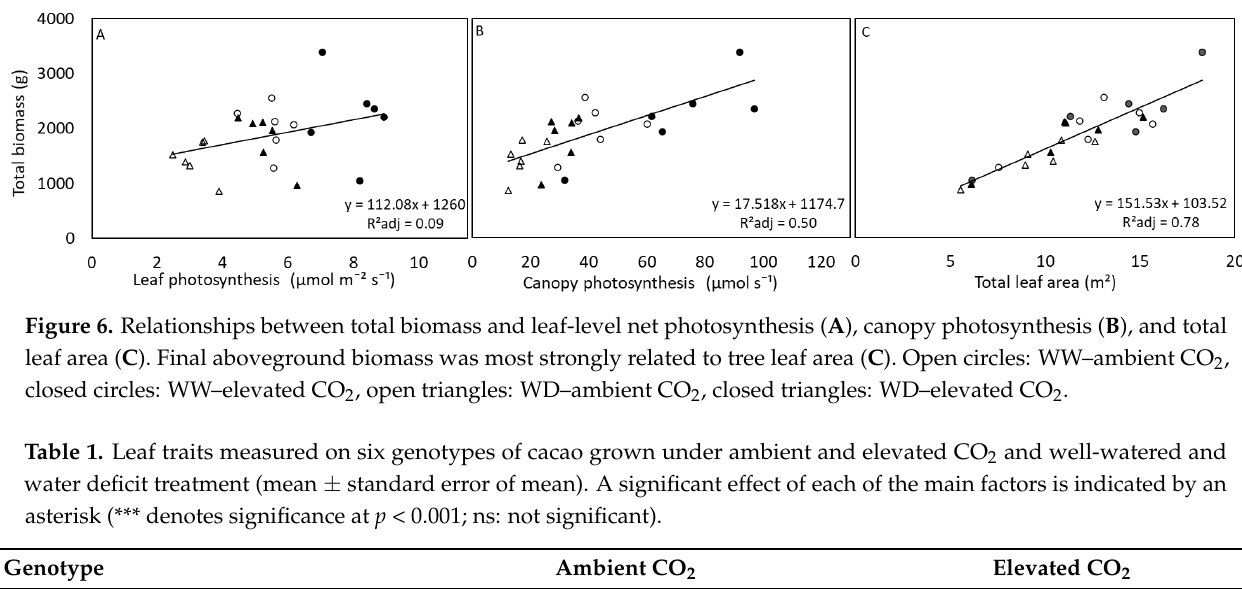
Figure 5. Tree biomass ( A ), wood and leaf mass fraction ( B ), and tree leaf area ( C ) in six genotypes of cocoa grown at elevated and ambient CO 2 and under well-watered (WW) and water deficit (WD) conditions. In ( C ) wood mass fraction is shown in the lower stacked bar in the lighter colour shade, leaf mass fraction is shown in the upper stacked bar in the darker shade. Error bars are standard error of the mean. Grey bars: CL 19/10; blue bars: ICS 1, orange bars: IMC 47; pink bars: POUND 7/B; yellow bars: SCA 6; green bars: SPEC 54/1. Where statistical differences were identified between the main factors, these are noted on the top right of each plot. The asterisks indicate the factors which had a significant effect on each response variable (W: water treatment; CO 2 : CO 2 treatment; G: genotype; * p < 0.05; ** p < 0.01; *** p < 0.001).